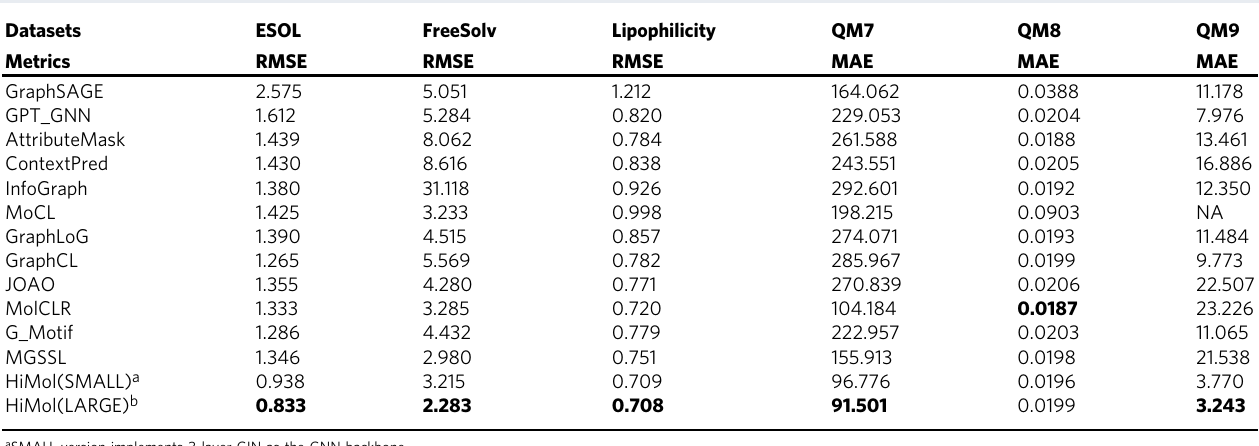
Table 2 Molecular property prediction performance on regression